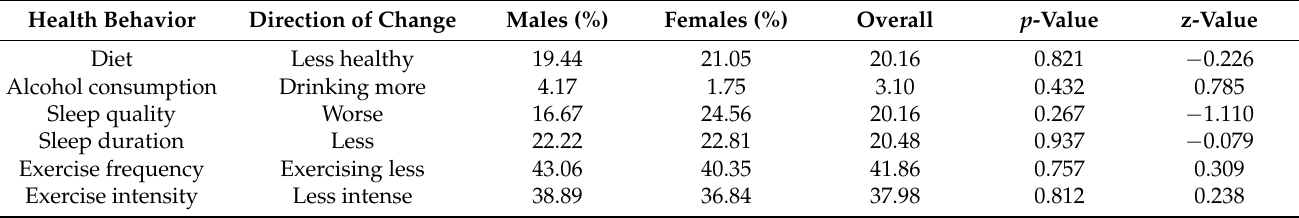
Table 4. Influence of the COVID-19 pandemic on health behaviors.